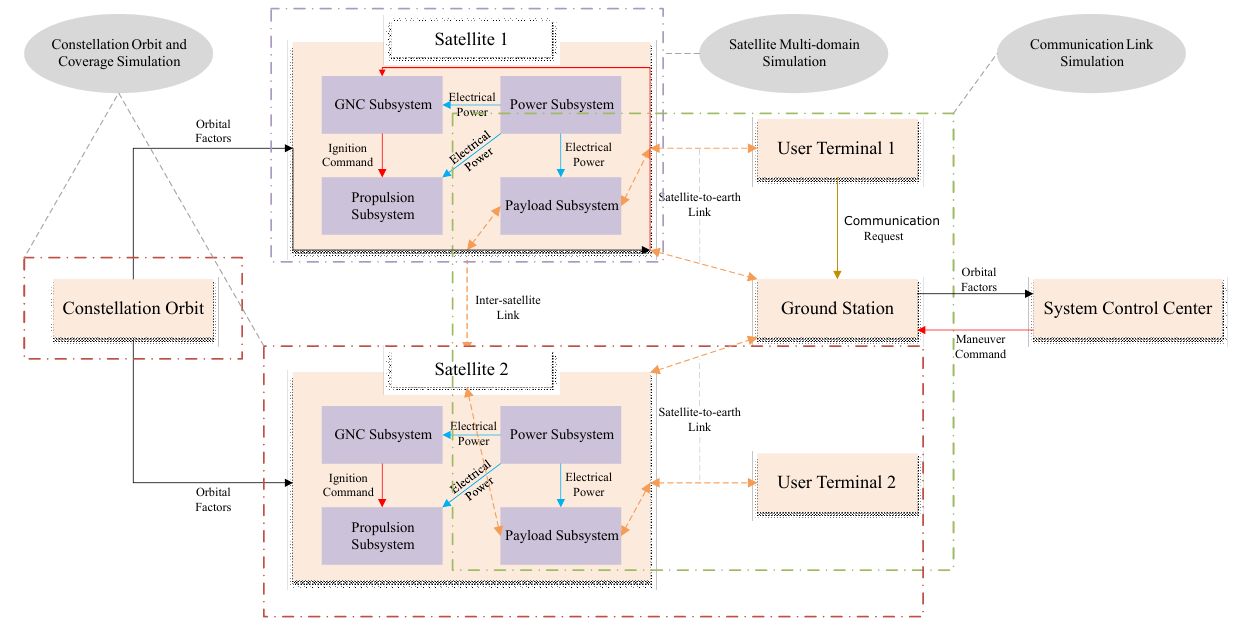
Figure 2. Model architecture of LEO communication satellite constellation